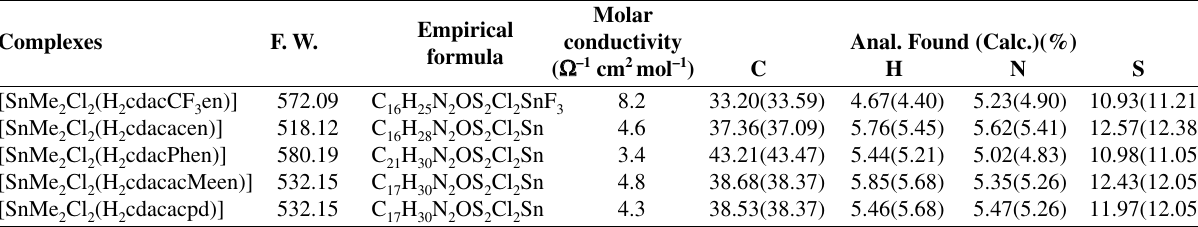
Table 1. The analytical data and physical properties of the Sn(IV) Schiff base complexes Complexes F. W.